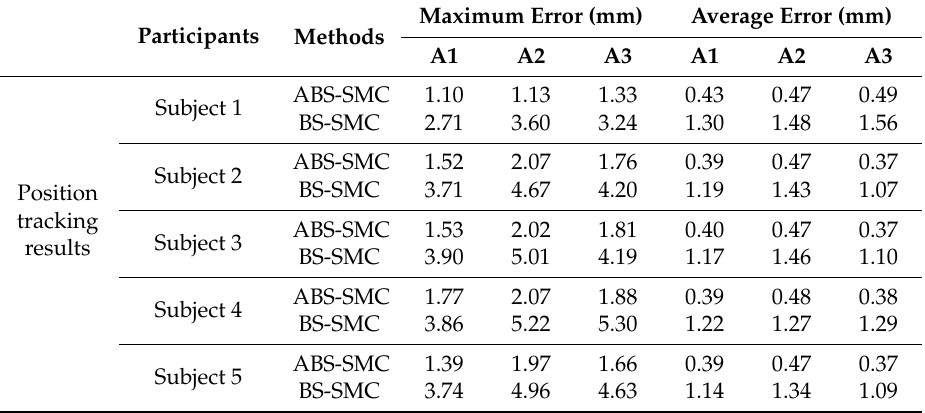
Table 4. Statistical analysis of actuator position tracking errors under different control methods (with five subjects).